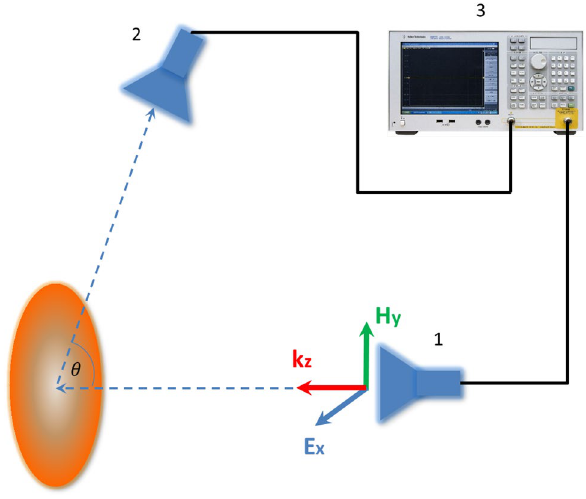
Figure 7. Sketch of experiment setup.1- transmitting antenna, 2- receiving antenna, 3-VNA Agilent E5071 C